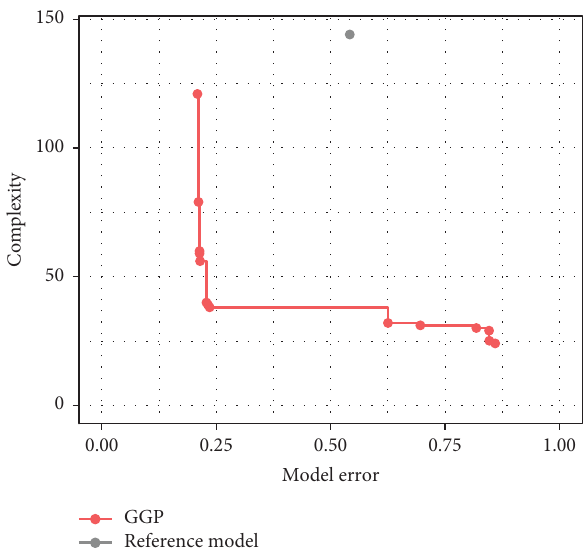
Figure 5: GGP structures on the Pareto front versus the reference structure (model error is the error when compared the simulated results against calibration targets; complexity is measured as the number of nodes in the tree of a GGP